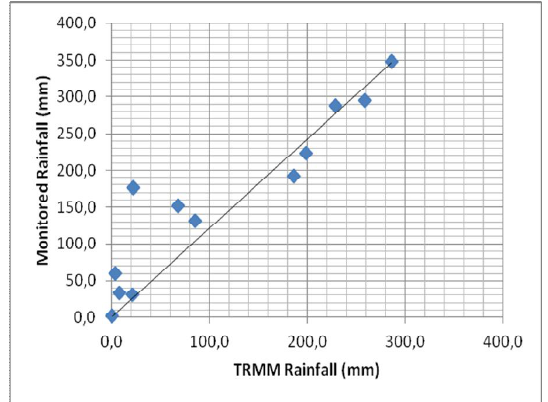
Figure 8. Linear agreement between TRMM and Monitored data on the monthly basis (year 2009)